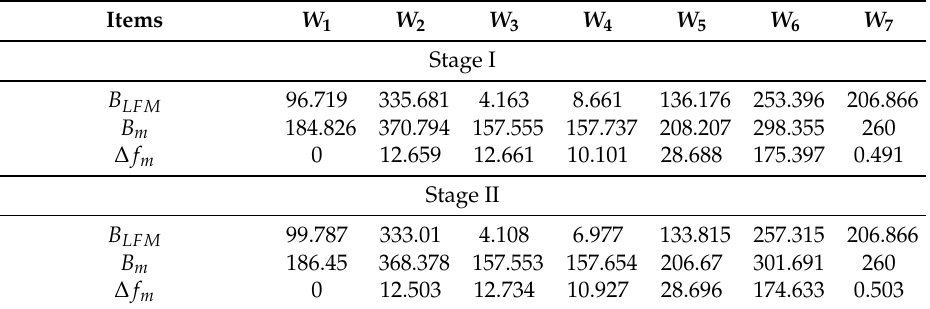
Figure 16. The iterative process of optimization in the second stage for the two-main-lobe. Similarly, the optimized bandwidths, frequency intervals, and phase-coded sequences of seven optimized waveforms after Stage I and Stage II are summarized in Tables 5 and 6 respectively. Table 5. Optimized bandwidths and frequency intervals for the two-main-lobe (/kHz).